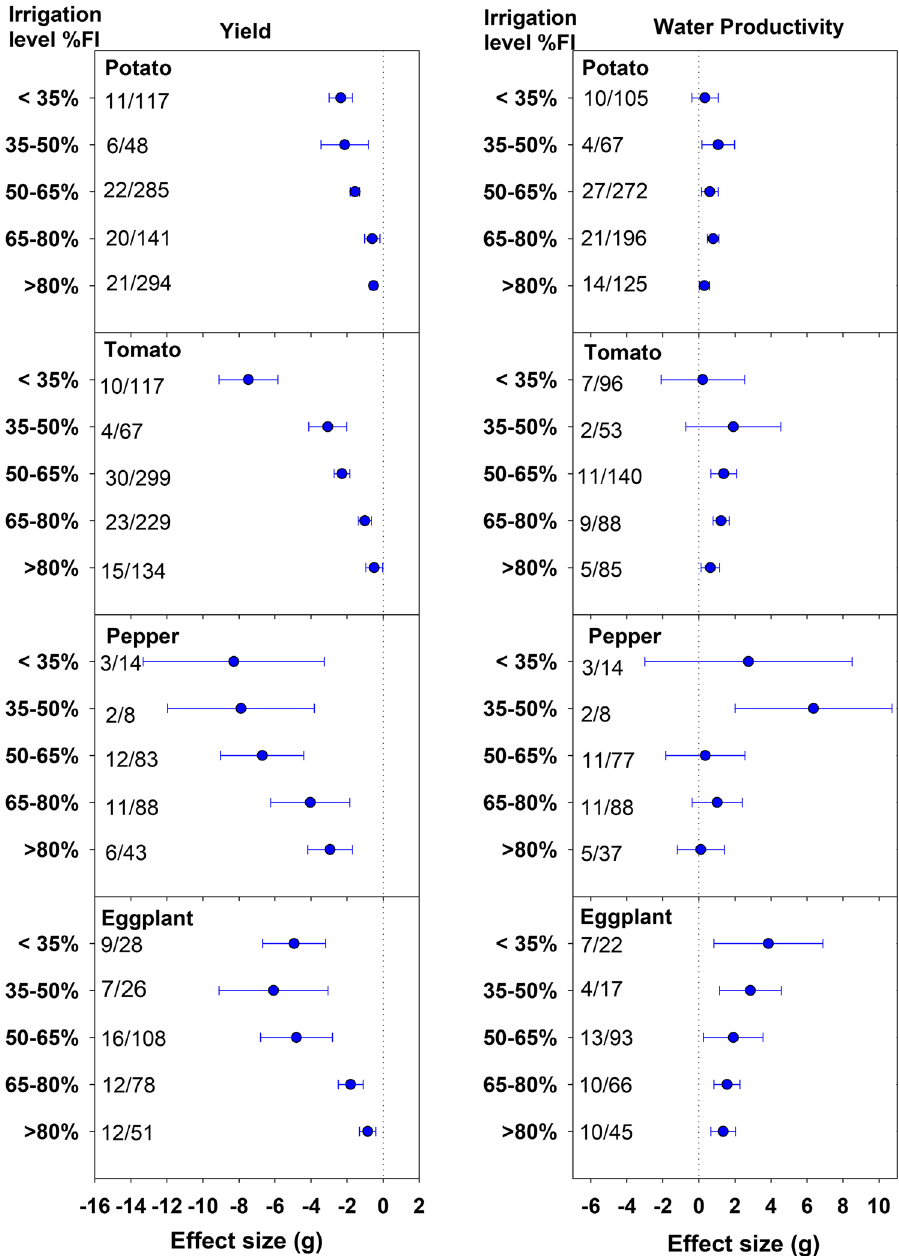
Figure 1. Effect of deficit irrigation levels on yield and water productivity (WP) of potato, tomato, pepper and eggplant. The dotted line (effect size = 0) represents full irrigation. Effect size > 0 indicates increase and effect size < 0 indicates reduction in yield and WP for deficit irrigation level relative to full irrigation (FI). Non- overlapping confidence intervals (horizontal bars) indicate significant differences. Numbers on right side of Y-axis represent number of